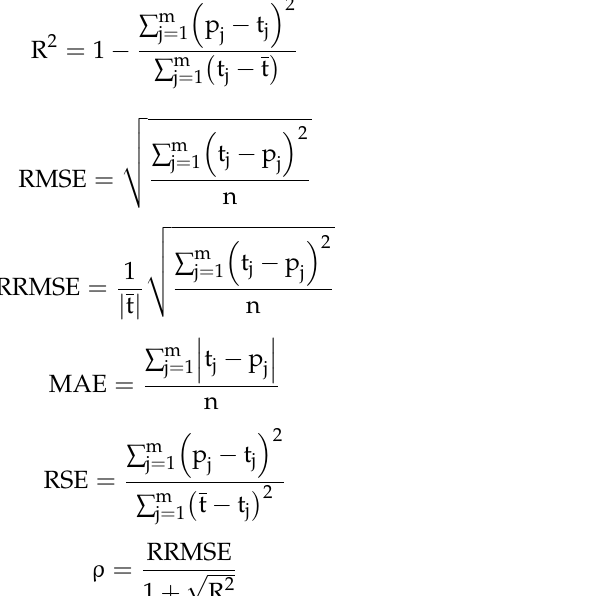
man square error (RMSE), relative root mean square (RRMSE), mean absolute error (MAE), relative squared error (RSE), and performance index ( ρ ). The mathematical relationship for stated chosen statistical measures is mentioned in Equations (4)–(9).